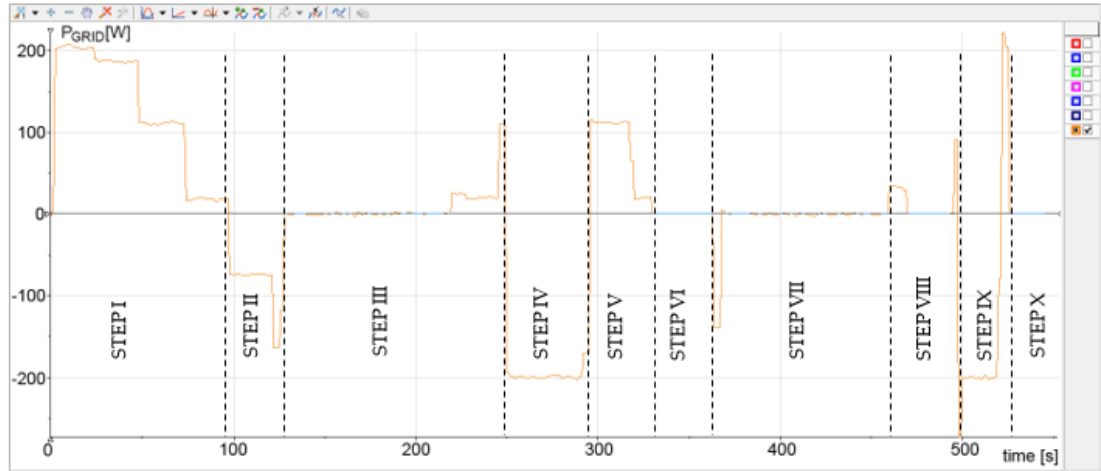
Figure 15. Power exchanged from the SUN with the grid.